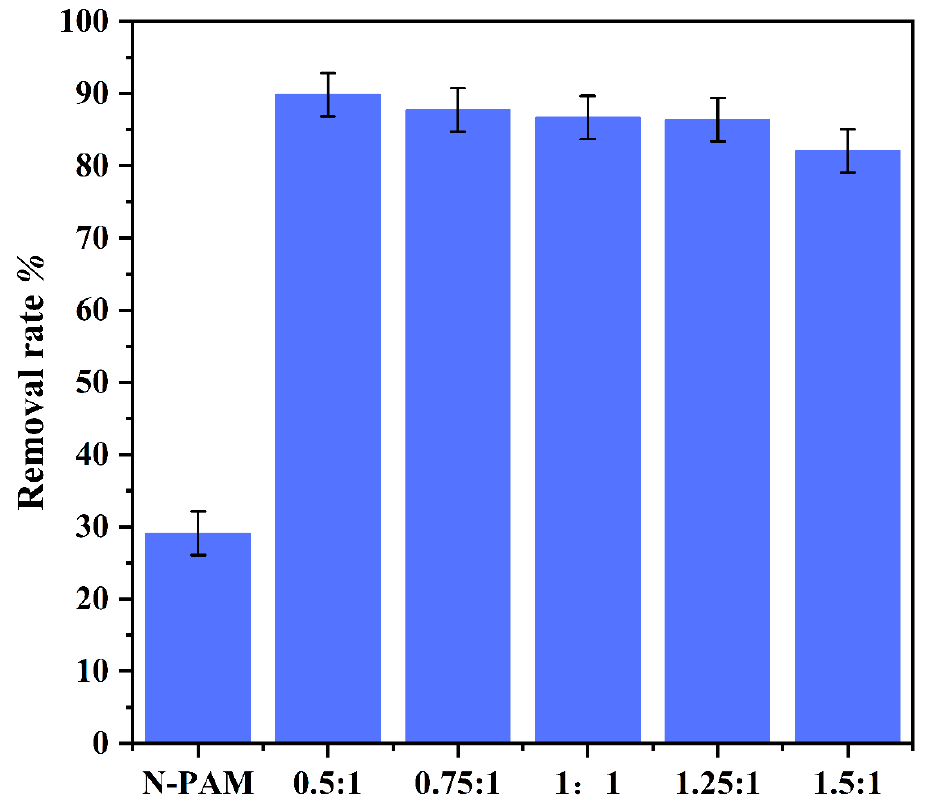
Figure 3. Removal rate of ReO 4 − by p-(Amide)-PAM generated by different reaction molar ratios. The dosage of the absorbent was 1 g/L, pH was 5.5, time was 240 min, initial concentration of ReO 4 − was 100 mg/L, and the temperature was 298.15 K.